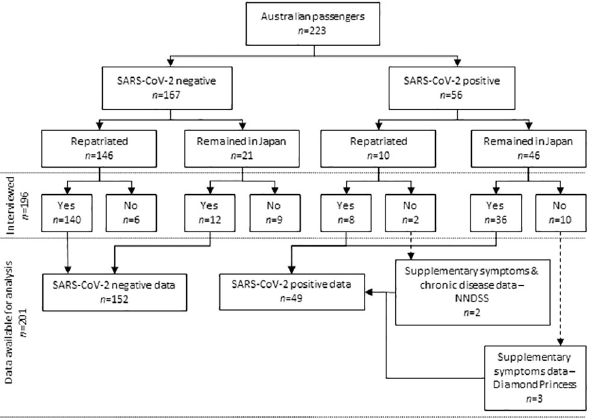
Fig 1. Flowchart of study recruitment and analysis of Australian passengers from the Diamond Princess cruise ship, March 2020.